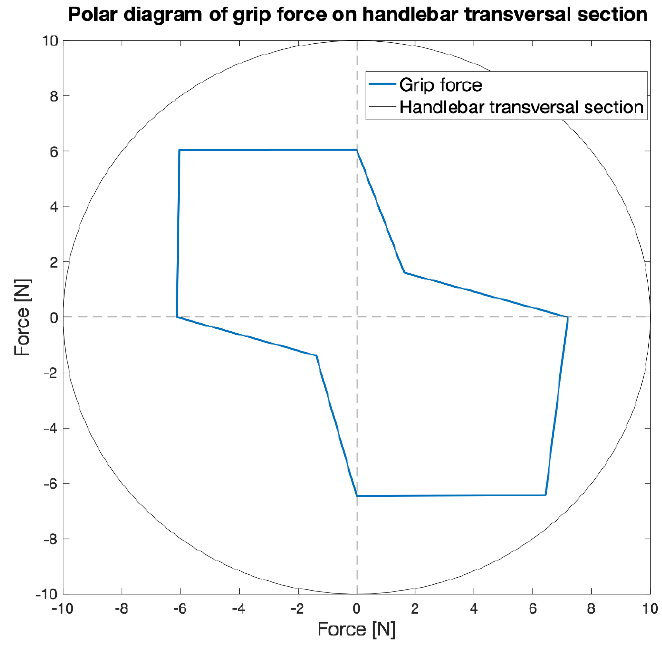
Figure 16. Polar diagram of the force measured by the load cell for the eight angles considered.